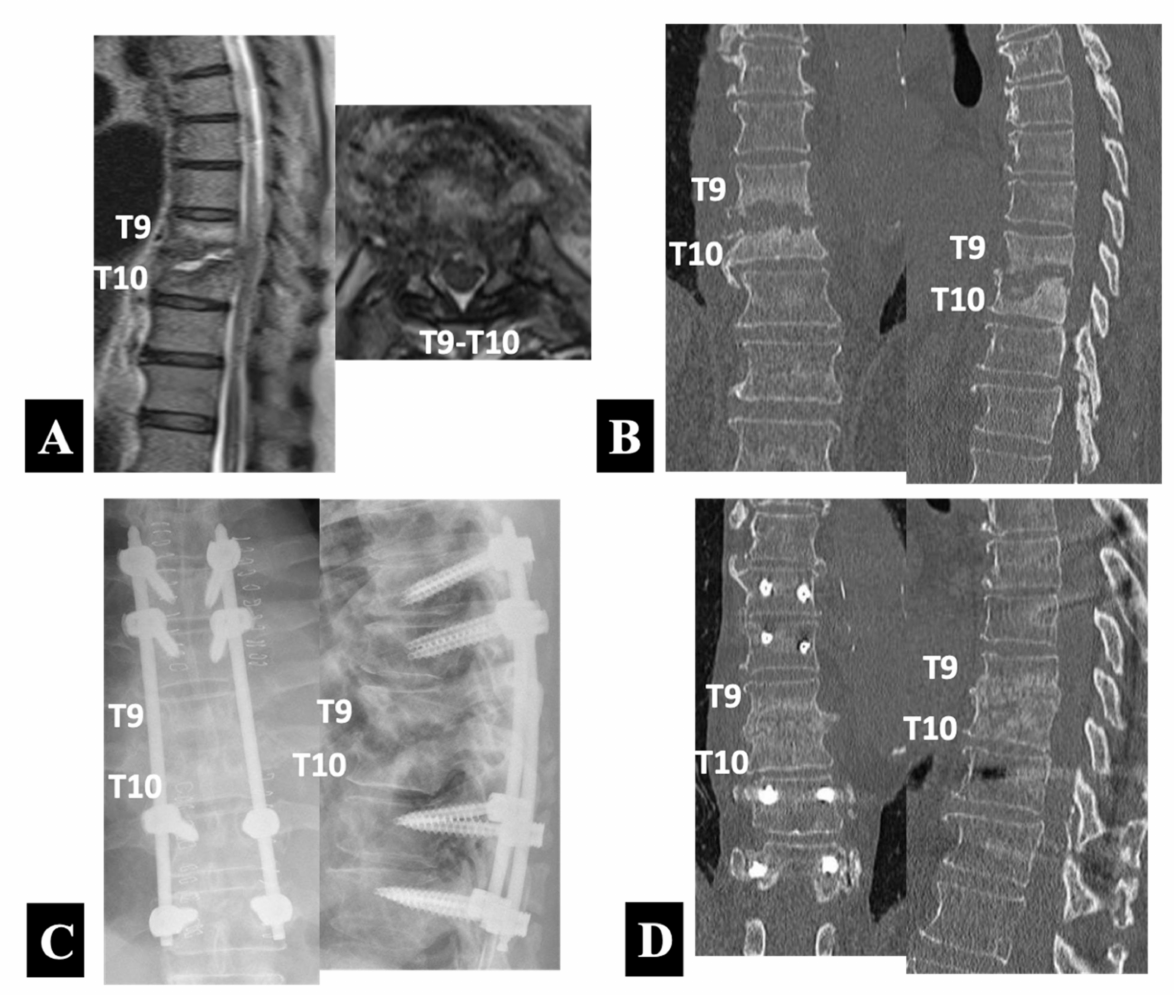
Figure 3. Preoperative sagittal and axial T2-weighted MRIs ( A ) and coronal and sagittal reformatted CT images ( B ) in a 66 year old neurologically intact man with pyogenic spondylodiscitis at T9 and T10. He underwent PPS–rod fixation alone with PPSs placed into the unaffected vertebrae of the T7 and T8 rostrally and the T11 and T12 caudally (Group 1-B) as shown by anteroposterior and lateral plain radiographs taken immediately after surgery ( C ) and coronal and sagittal reformatted CT images 9 months postoperatively ( D